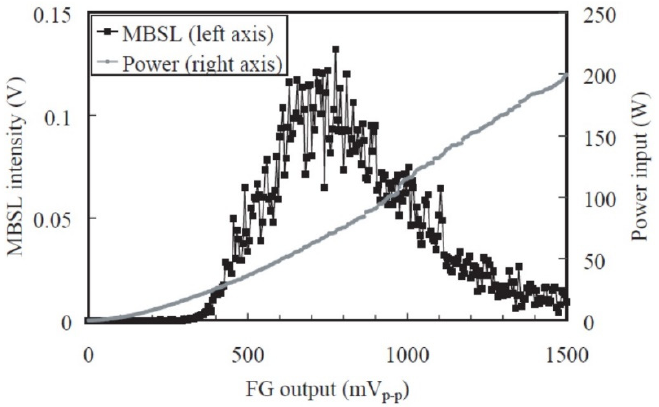
Figure 30. Dependence of MBSL intensity on FG output at 23 kHz and changes of power input to the transducers [69]. Copyright 2001, with the permission from IOP Publishing.